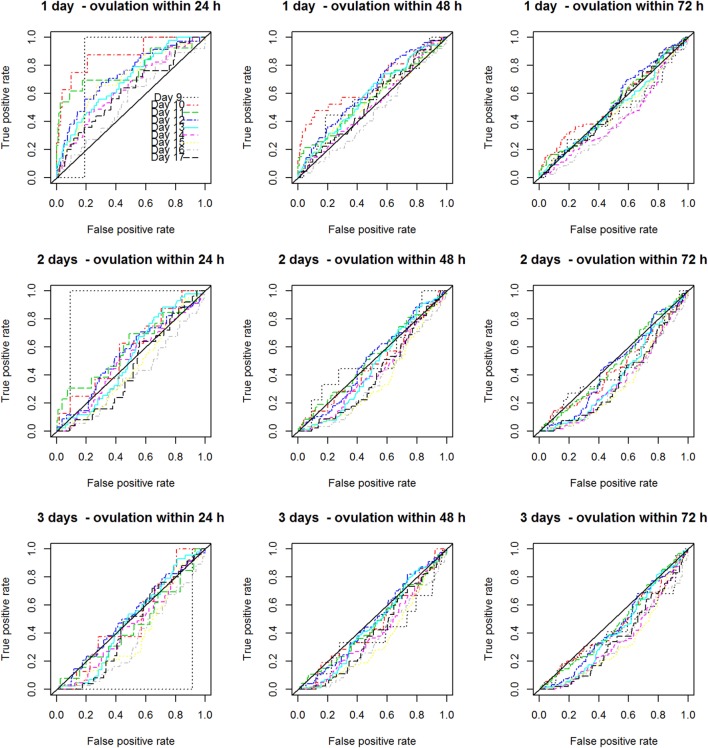
Nine ovulation predictive scenarios for the proportion of true-positive rates to false-positive rates from days 9 to 17 of the cycles.